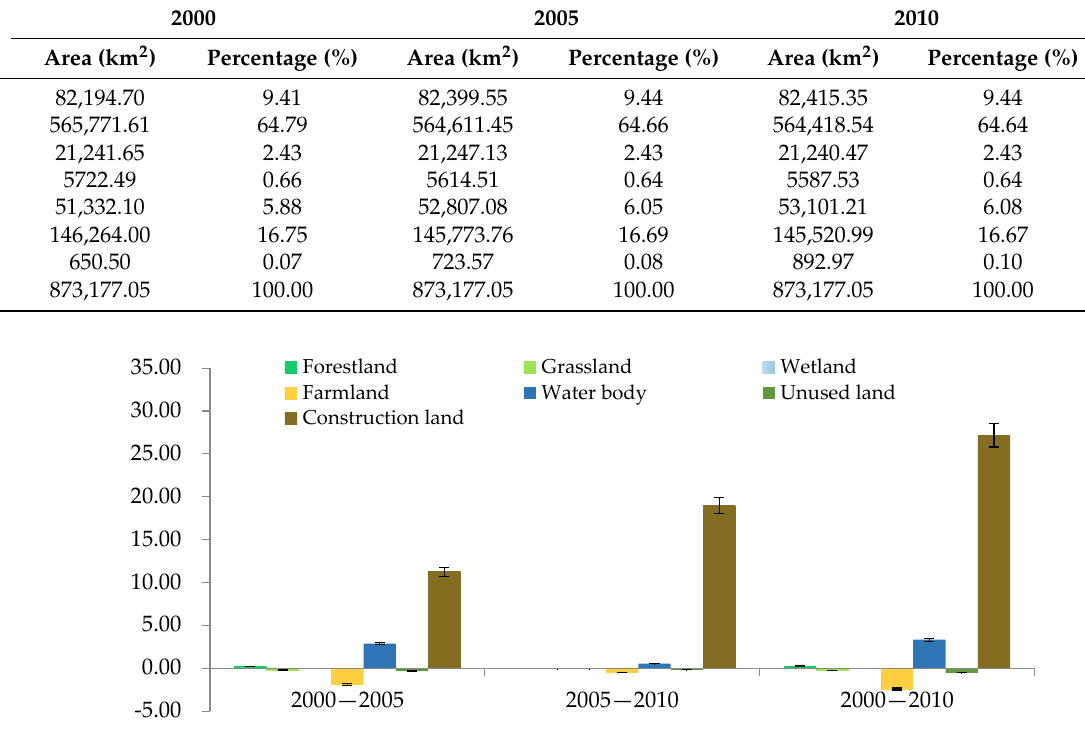
Figure 5. Dynamic rates of land-use types.